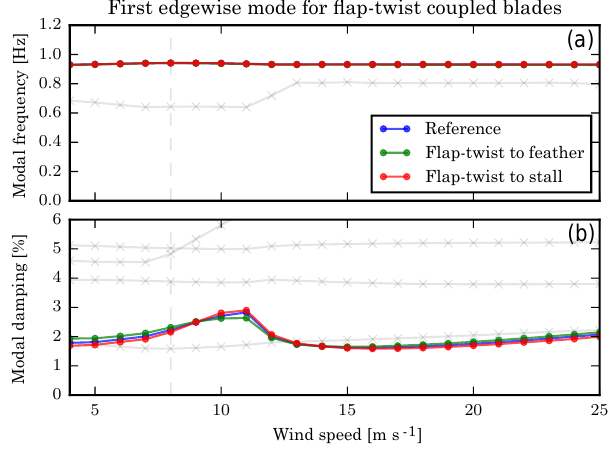
Figure 11. Aeroelastic frequency (a) and damping ratio (b) over the operational wind speed range of the first edgewise blade-only mode for the reference and flap–twist coupled blades with coupling coefficients γ y = ± 0 . 1. The grey solid lines indicate other blade modes of the reference blade. The grey dashed line indicates the pretwisting reference speed of 8ms − 1